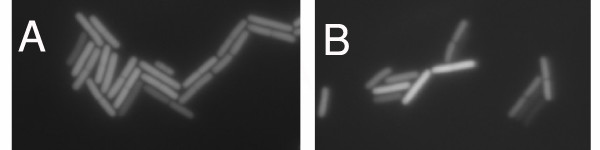
Localization of GFP-MAP_Bs and GFP-YflG_Bs fusions. A. Localization of GFP-MAP_Bs in strain BSIP8001 grown in minimal medium with 0.5% xylose (w/v); B. Localization of GFP-YflG_Bs in strain BSIP8002 grown in minimal medium with 1% xylose (w/v).